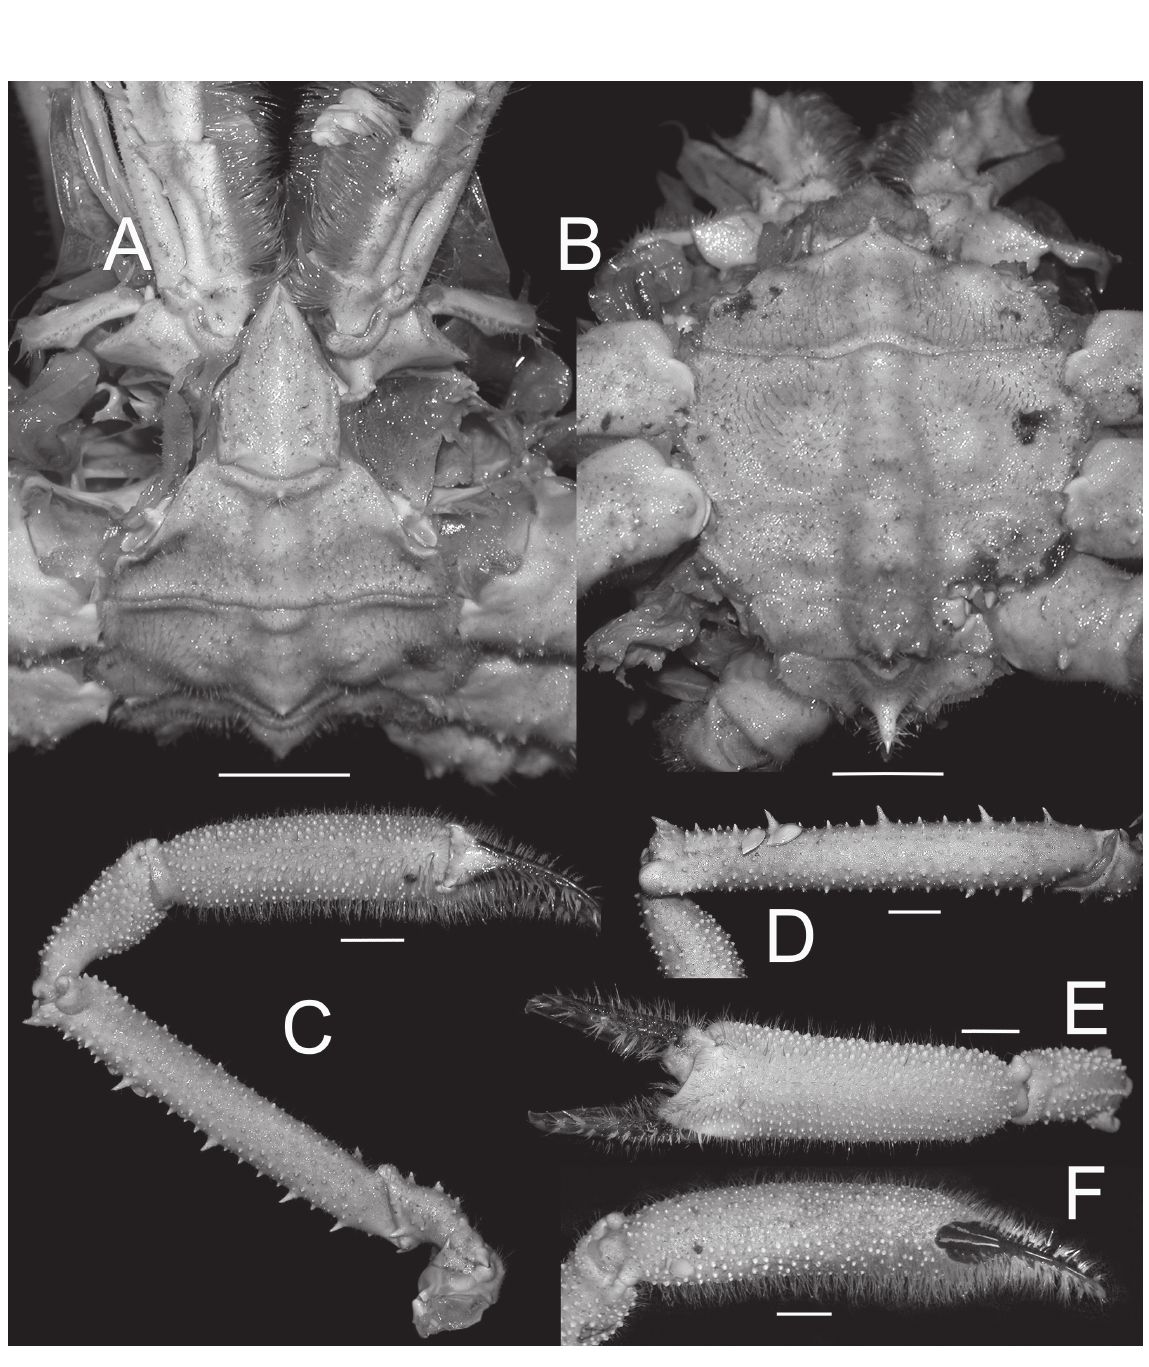
Fig. 8. Moloha alisae Guinot & Richer de Forges, 1995. A – B . ♂ (cl 67.7 mm, cw 56.2 mm) (ZRC 2008.1250a), South Africa. C – F . ♂ (cl 67.5 mm, cw 56.5 mm) (ZRC 2008.1250b), South Africa. A . Telson and pleonal somites 5 and 6. B . Pleonal somites 2–6. C . Left cheliped. D . Lateral view of merus and carpus of left cheliped. E . Outer view of right chela. F . Ventro-marginal view of right chela. Scale bars = 10